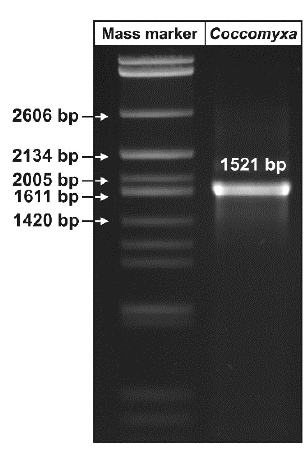
Figure 2. Electropherogram of the PCR product specific to Coccomyxa species.